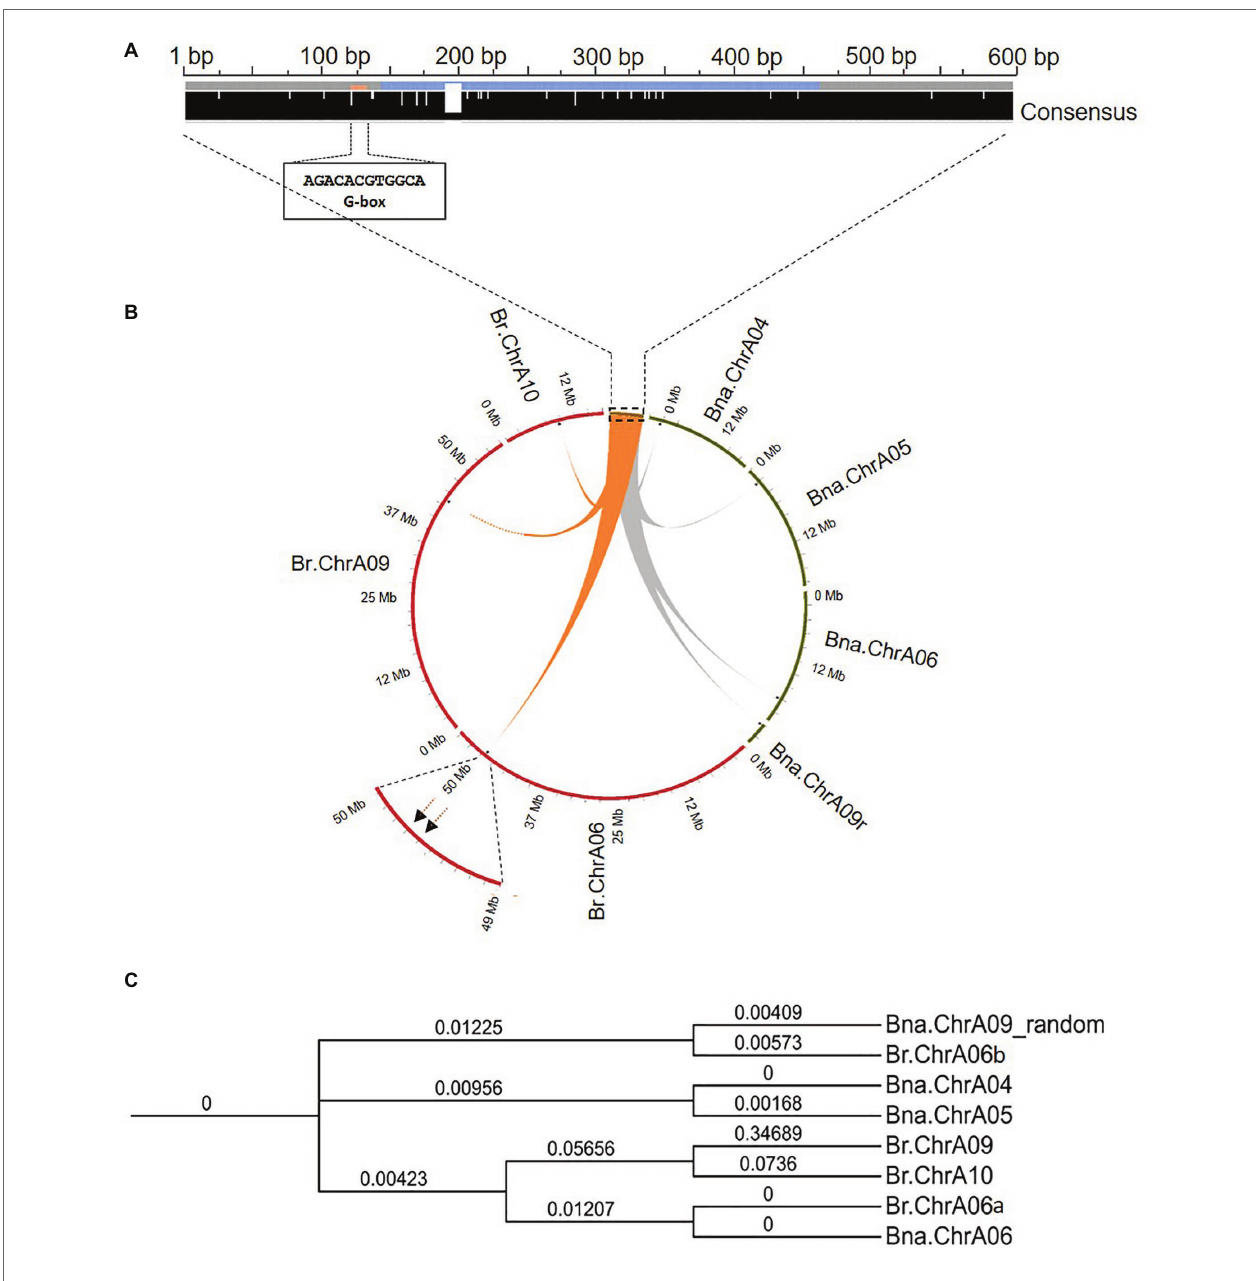
FIGURE 2 | Sequence analysis and genomic positions of the insertion-homologous sequences in Brassica napus and Brassica rapa . (A) Multiple sequence alignment of the four homologous sequences from B. napus , showing consensus (black bar) with a high modal residue per column, and the postion of the G-box HY5 binding motif. Blue color in the middle of the insertion sequence corresponds to the region matching to SRO2 . (B) Circos plot showing genomic positions of the insertion-homologous sequences on chromosomes of B. rapa (red) and B. napus (green). (C) Phylogenetic tree showing the evolutionary relationship between the eight identified sequences in the genomes of Bna. napus and B. rapa